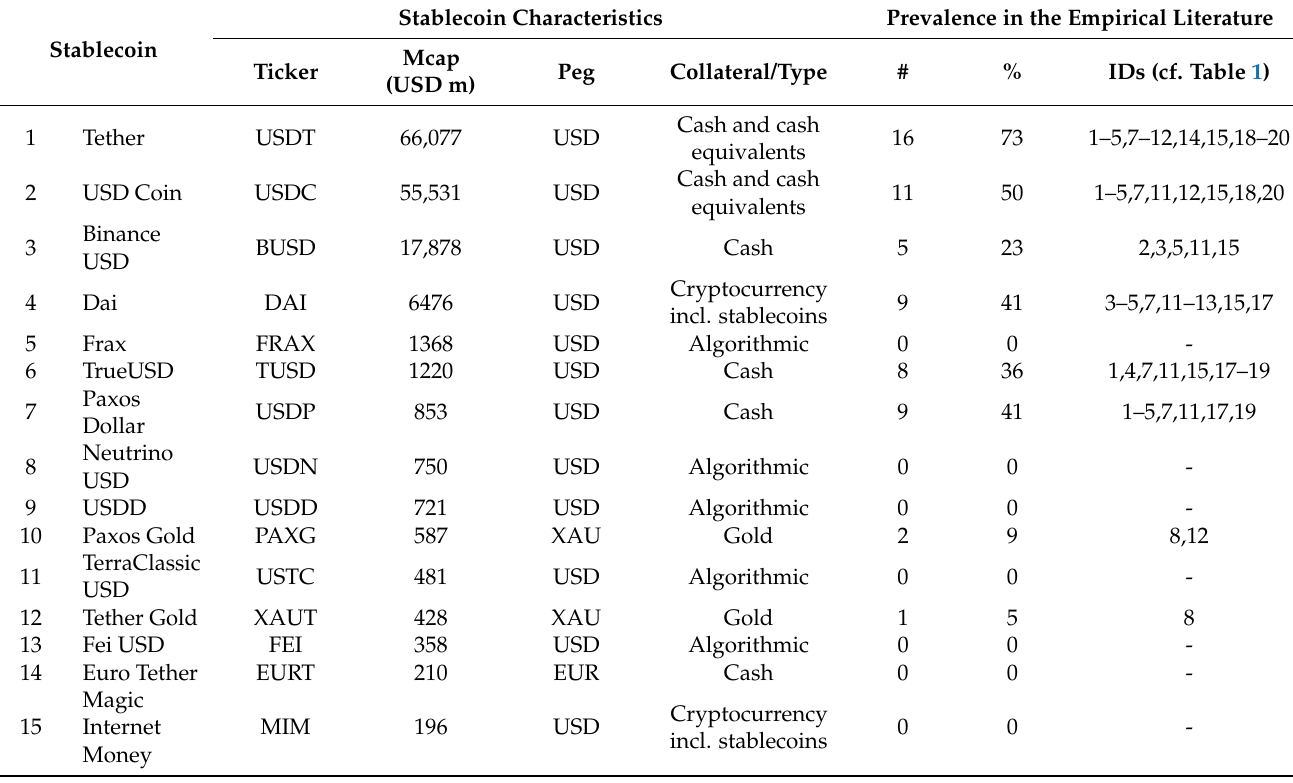
Table 2. Twenty largest stablecoins, their characteristics, and prevalence in the empirical